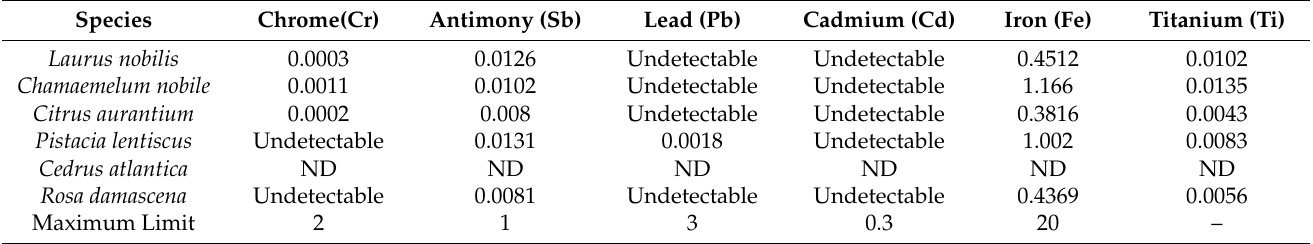
Table 2. Concentration of heavy metals (mg/L) (ICP) and FAO/WHO Maximum Limit